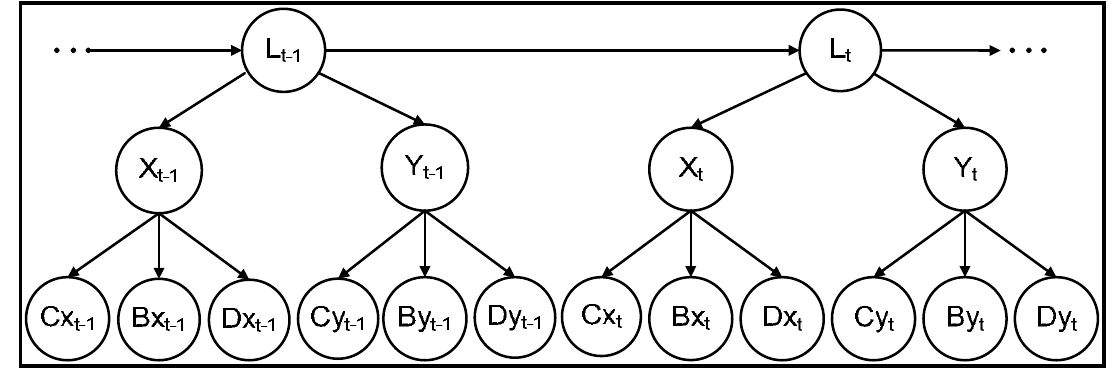
Figure 7. A Dynamic Link Prediction Bayesian network